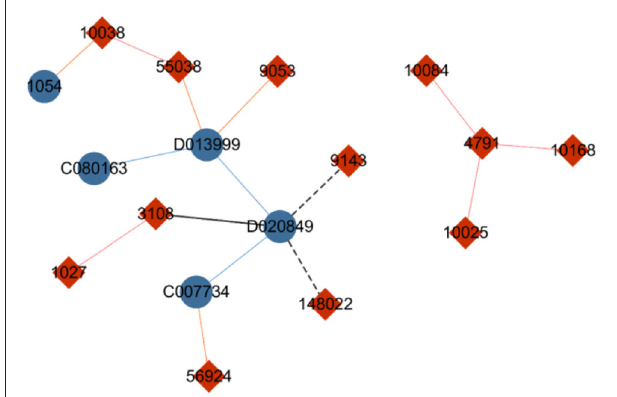
FIGURE 3 | Diagram of drug–gene network. The blue nodes indicate drugs, and the red nodes indicate genes. The solid lines represent drug–gene interactions, with the blue lines indicating a similarity between two drugs, and the red lines indicating a similarity between two genes. The black line means that the nodes are selected as candidate labels of drug “D020849,” and the dotted line indicates that the node on the end side of the line is a sampled